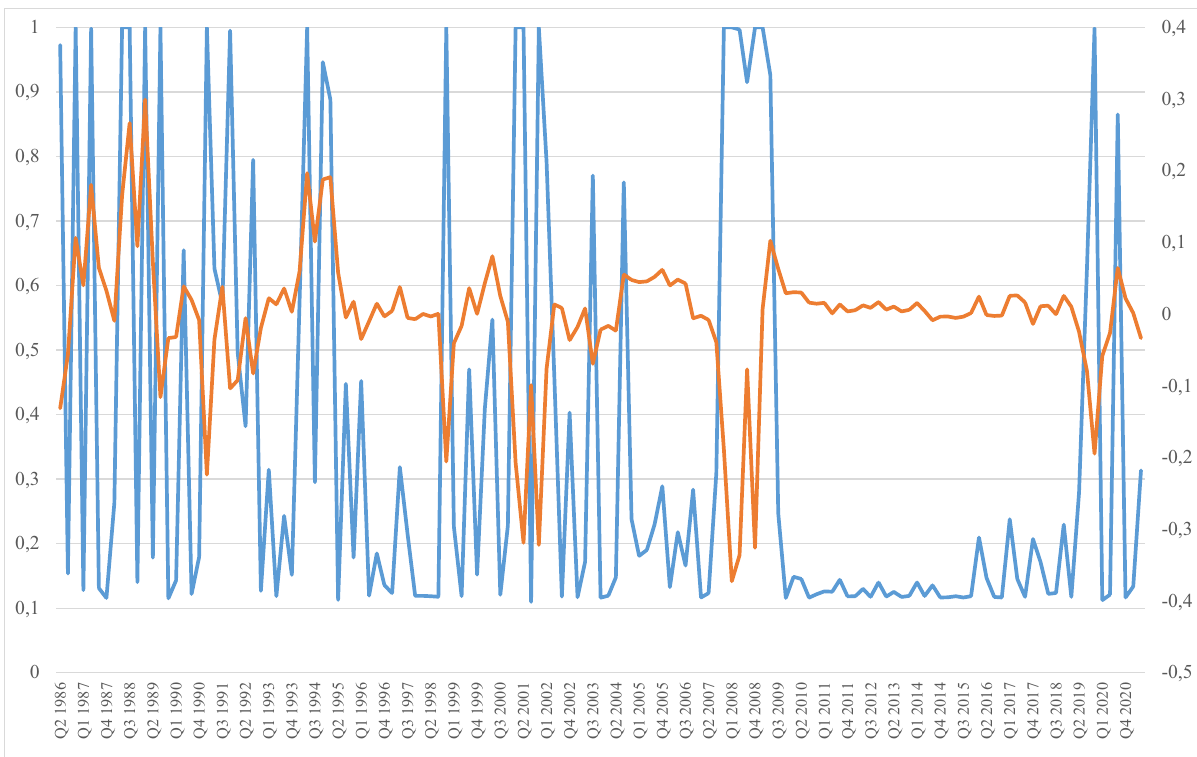
Estimated deviation of the current inflation target from its long-term mean Figure 2: Monetary policy with time - varying in fl ation